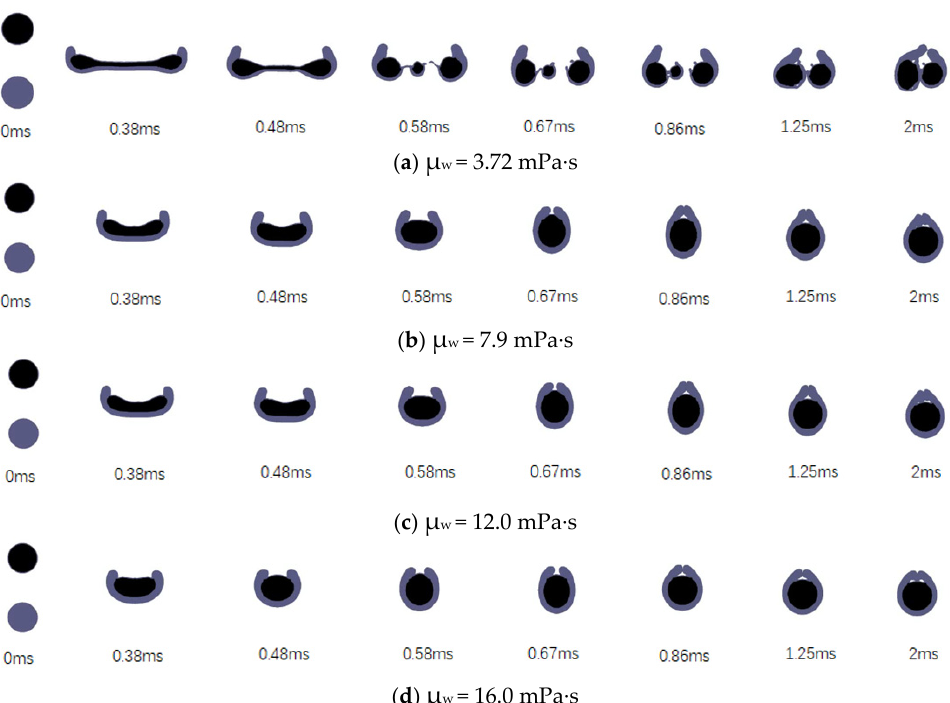
Figure 7. Simulated images of the collision process between a water/glycerol droplet and a silicone oil droplet ( We = 47.7) at different viscosities of the aqueous phase: ( a ) 3.72 mPa · s; ( b ) 7.9 mPa · s; ( c ) 12.0 mPa · s; ( d ) 16.0 mPa · s.